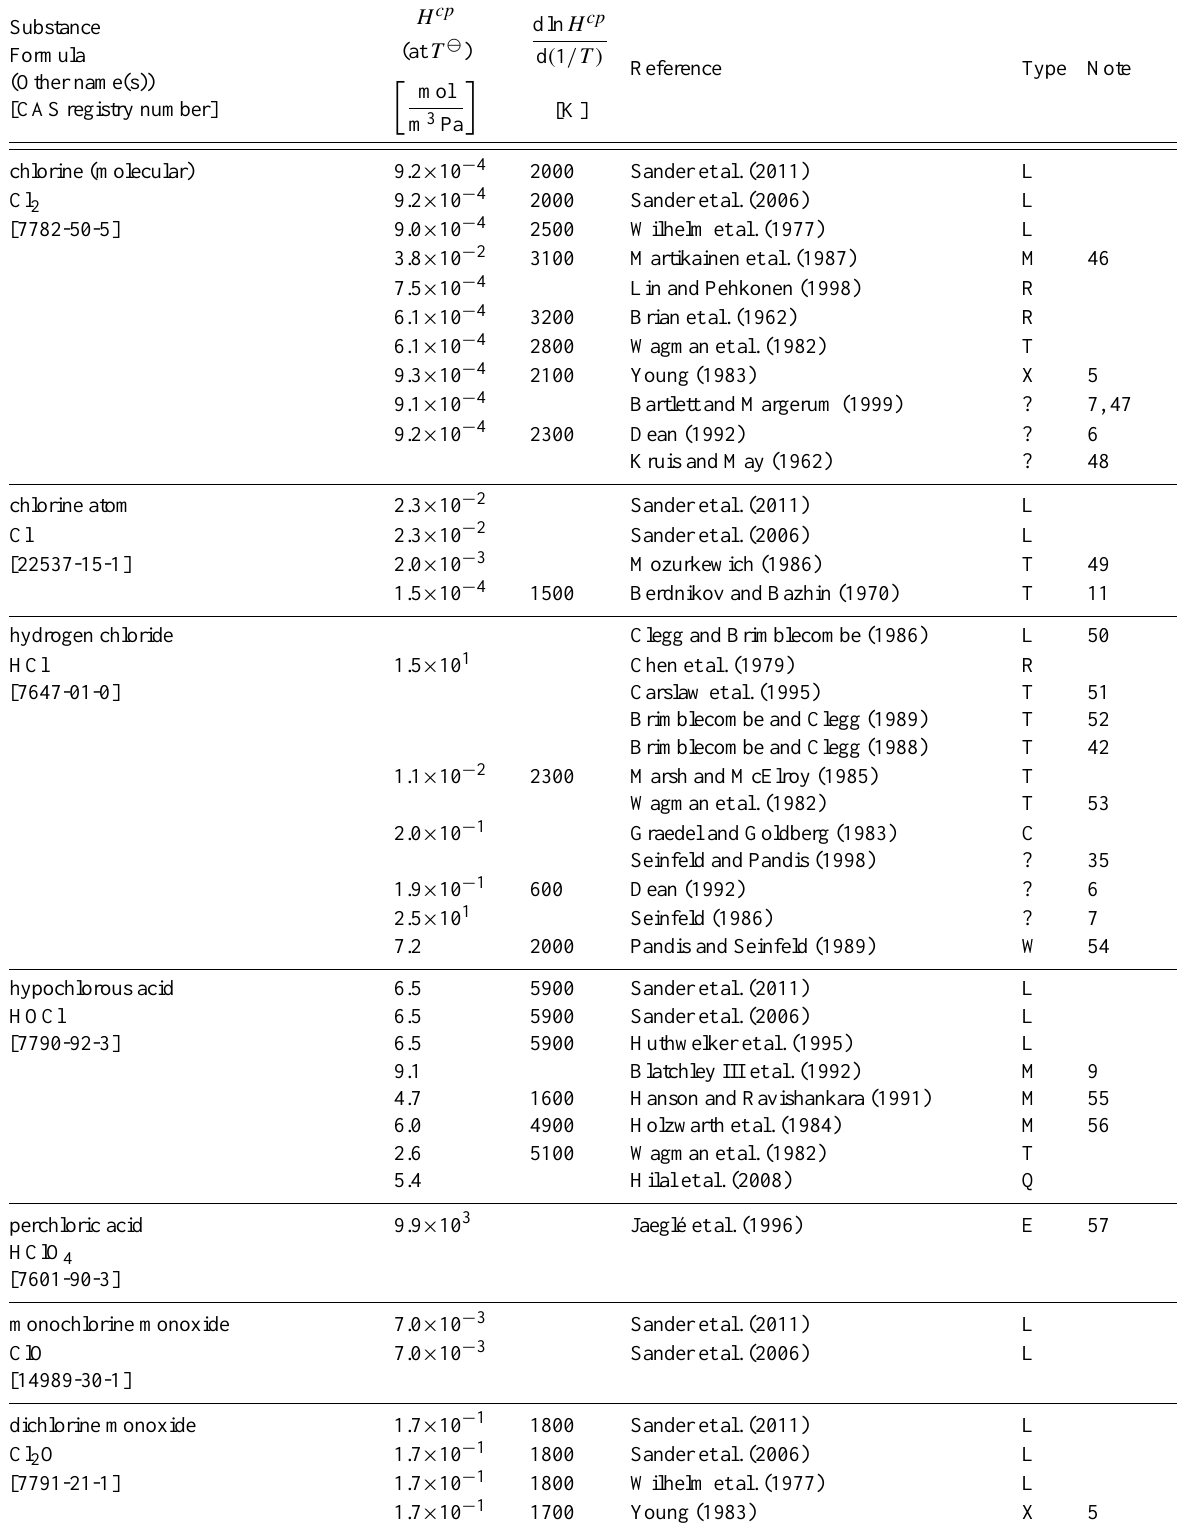
Table 6: Henry’s law constants for water as solvent